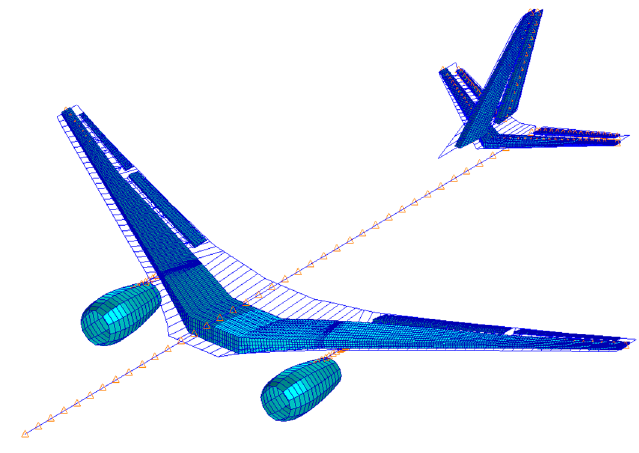
Figure 2. Global FE model of the XRF1-DLR-C.